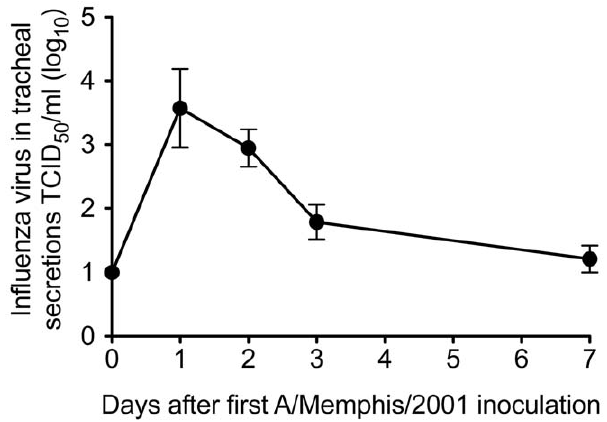
Figure 1. Influenza virus replication in the lower respiratory tract after A/Memphis/7/01 inoculation. Mean infectious virus titer in tracheal secretions (TCID 50 /ml) of nine inoculated rhesus macaques.